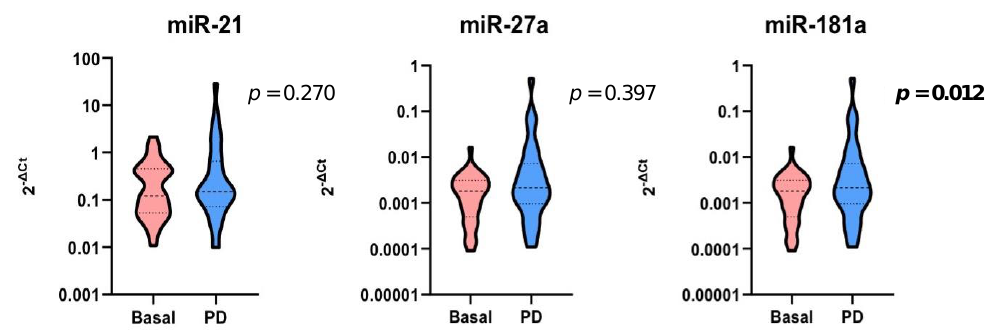
Figure 4. Modulation of miRNA expression at the time of progression to EGFR-TKI compared to baseline. Significant p values are in bold. Dashed lines represent the median values. Dotted lines represent the upper and lower